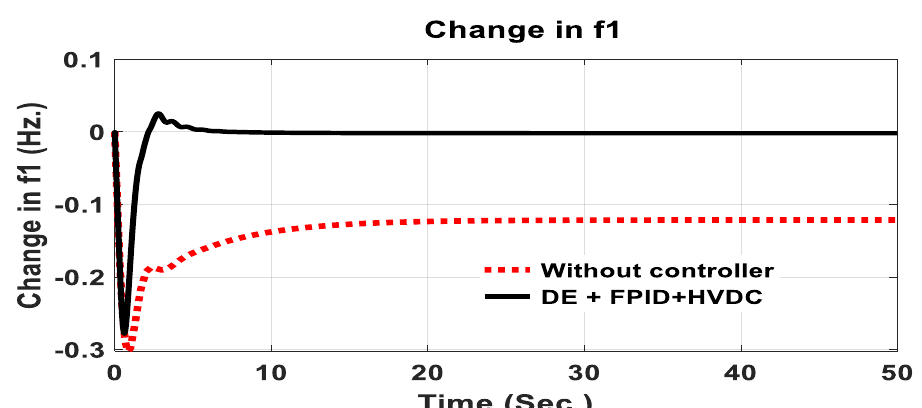
Figure 5. Comparison of controller and without controller for frequency deviation f1.